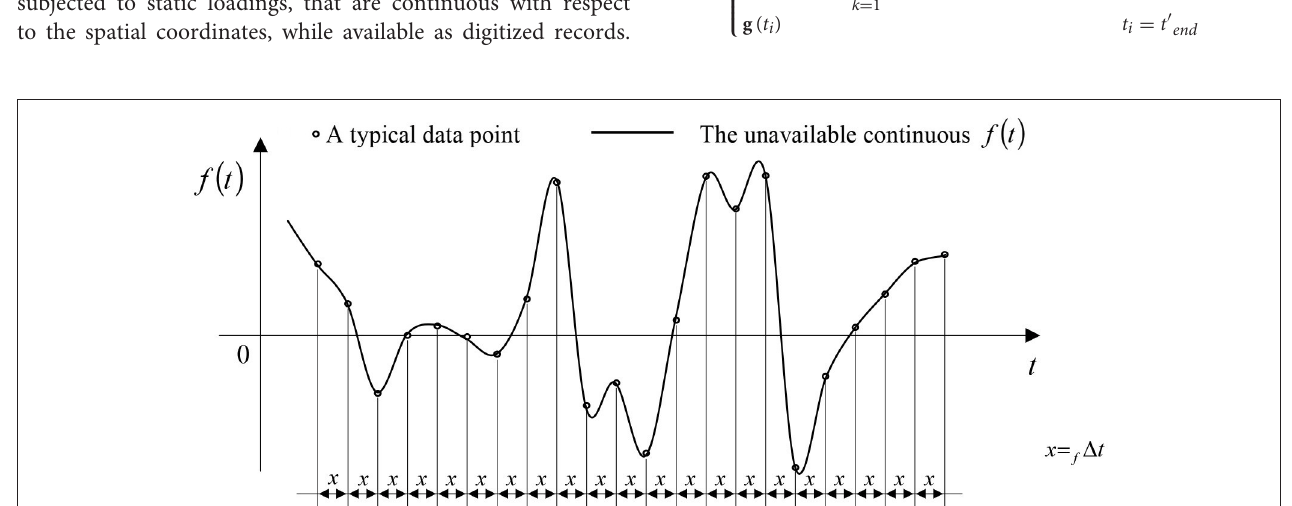
FIGURE 1 | A typical digitized component of f ( t )